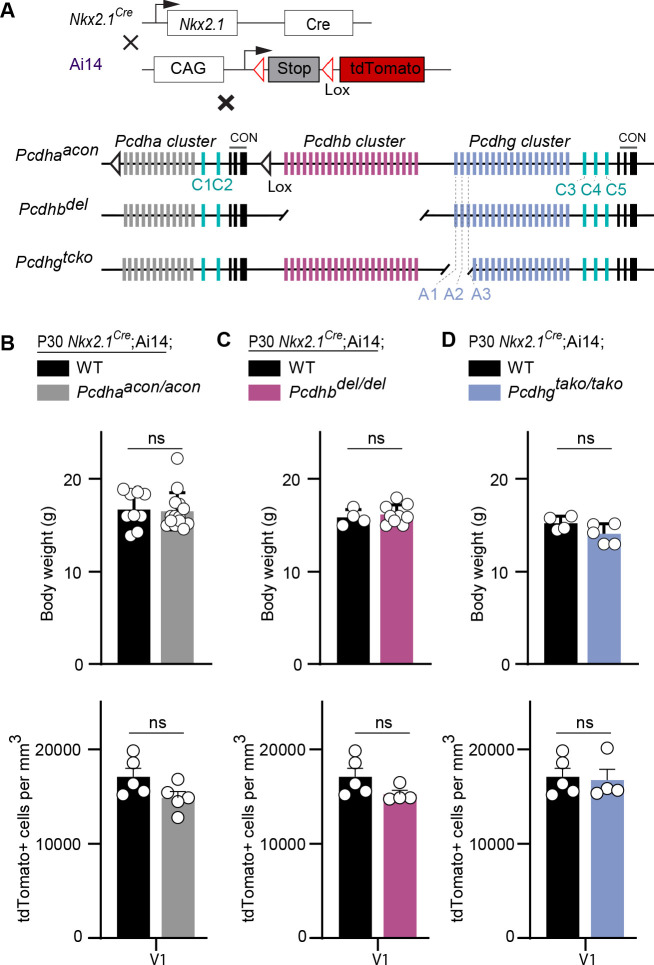
Loss of Pcdha, Pcdhb, or Pcdhga1, Pcdhga2, and Pcdhga3 genes does not affect the survival of MGE-derived cINs.(A) Mutant mice with loss of Pcdha, Pcdhb or Pcdhga1, Pcdhga2, and Pcdhga3 genes in MGE-derived cINs were generated by crossing Pcdhaacon, Pcdhbdel, and Pcdhgtako mice to the Nkx2.1Cre mouse line. The conditional Ai14 line was used to fluorescently label MGE-derived cells. (B) Measurements of body weight (top graph) in P30 Nkx2.1Cre;Ai14;Pcdha+/+ (Pcdha WT, black bar) and Nkx2.1Cre;Ai14;Pcdhaacon/acon (Pcdha mutant, grey bar) mice (Mann-Whitney test, p=0.545, n = 9–14 mice of each genotype). Quantification of the density of MGE-derived cINs (bottom graph) in primary visual cortex (V1) of Pcdha WT (black bar) and Pcdha mutant (grey bar) P30 mice (Mann-Whitney test, p=0.9603, n = 4–5 mice of each genotype). (C) Measurements of body weight (top bar) in P30 Nkx2.1Cre;Ai14;Pcdhb+/+ (Pcdhb WT, black bar) and Nkx2.1Cre;Ai14;Pcdhbdel/del (Pcdhb mutant, pink bar) mice (Mann-Whitney test, p=0.712, n = 4–9 mice of each genotype). Quantification of the density of MGE-derived cIN (bottom graph) in primary visual cortex (V1) of Pcdhb WT (black bar) and Pcdhb mutant (pink bar) P30 mice (Mann-Whitney test, p=0.1111, n = 4–5 mice of each genotype). (D) Measurements of body weight (top graph) in Nkx2.1Cre;Ai14;Pcdhg+/+ (Pcdhg WT, black) and Nkx2.1Cre;Ai14;Pcdhgtako/tako(Pcdhga1, Pcdhga2, and Pcdhga3 mutant, blue bar) P30 mice (Mann-Whitney test, p=0.175, n = 4–5 mice of each genotype). Quantification of the density of MGE-derived cINs (bottom graph) in in primary visual cortex (V1) of Pcdhg WT (black bar) and Pcdhga1, Pcdhga2, and Pcdhga3 mutant (blue bar) P30 mice (Mann-Whitney test, p=0.9048, n = 4–5 mice of each genotype).
Figure 7—source data 1.Analysis of Nkx2.1-derived cINs in P30 control, Pcdha, Pcdhb and Pcdhg mutant mice.